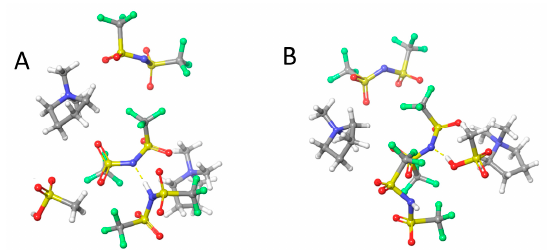
Figure 8. B3LYP / 6-31 + G* structures of MSA / HTFSI / PyrrTFSI AILs. For computational simplicity, the cation is 1,3-dimethylimidazolium. ( A ) N-H-N “bridged” structure, in which the HTFSI is hydrogen-bonded to a TFSI anion while the MSA is not involved in hydrogen bonding; ( B ) N-H-O “bridged” structure, in which the MSA is hydrogen bonded to a TFSI anion.